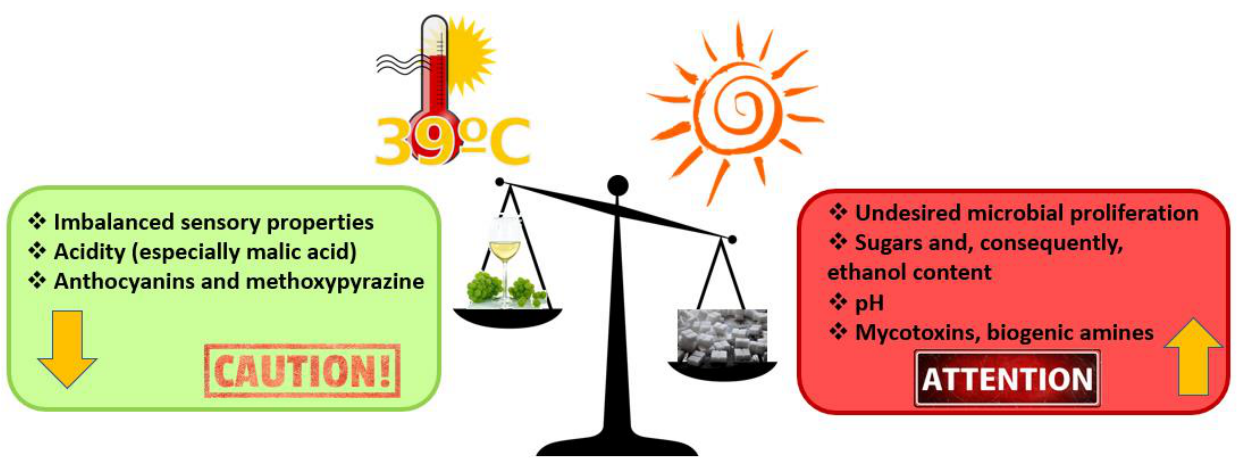
Figure 1. Main effects of rising temperatures on the bunch [40,42,43].